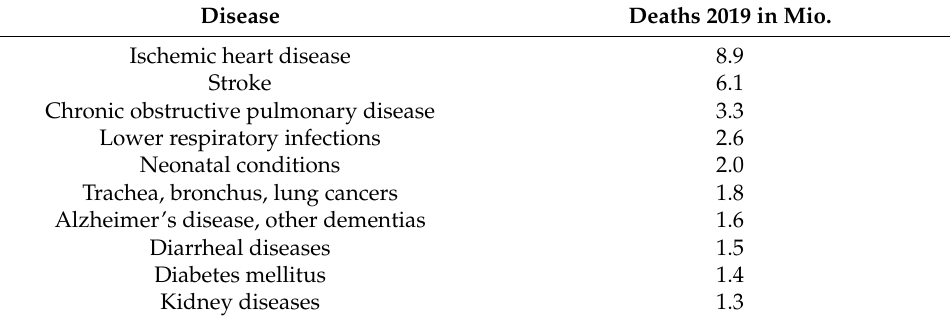
Table 2. Leading causes of death globally. Disease Deaths 2019 in Mio. Ischemic heart disease 8.9 Stroke 6.1 Chronic obstructive pulmonary